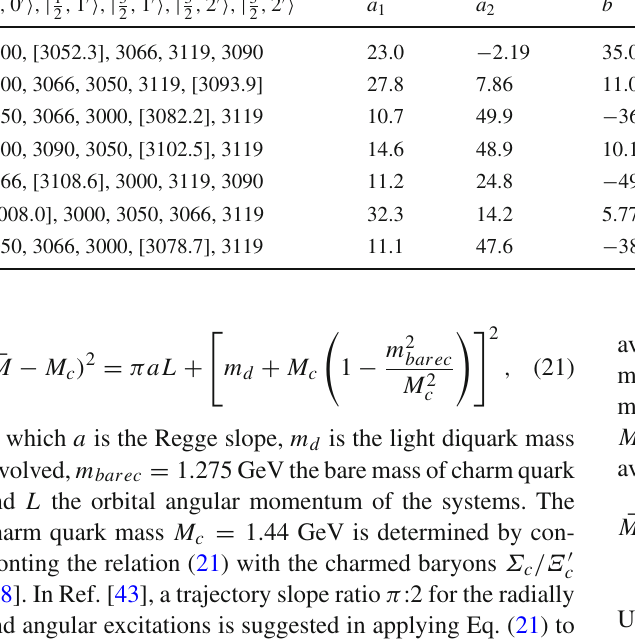
Table 3 Parameters and spin-averaged masses (MeV) for the selected permutations of J P assignments of the four states out of excited Ω c levels. Only the arrangements that leads to the parameters near to rea- sonable values are listed among 5 ∗ 4 ! = 120 possible permutations of